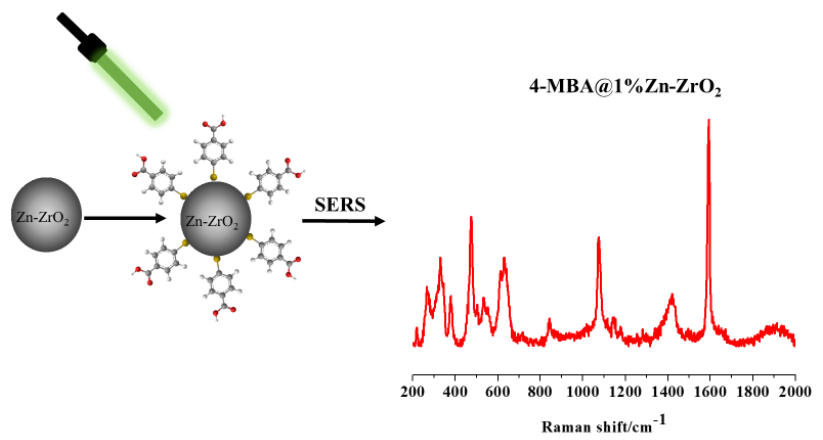
Figure 1. Diagram of the Zn–ZrO 2 (1%) NPs and 4–MBA.